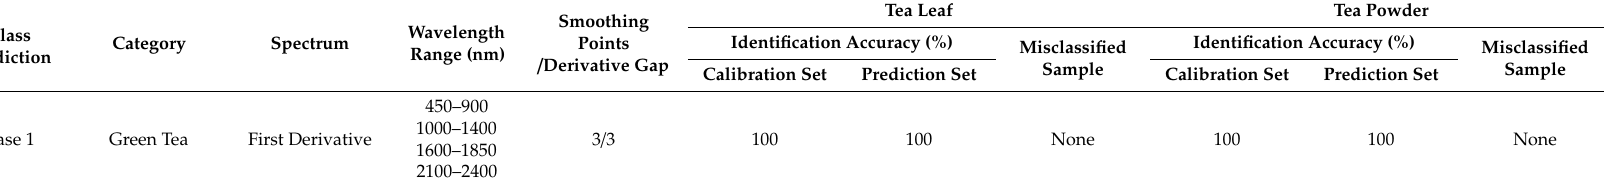
Table 5. Discrimination of the types, origins, and production areas of tea leaves and powders using support vector machine classification